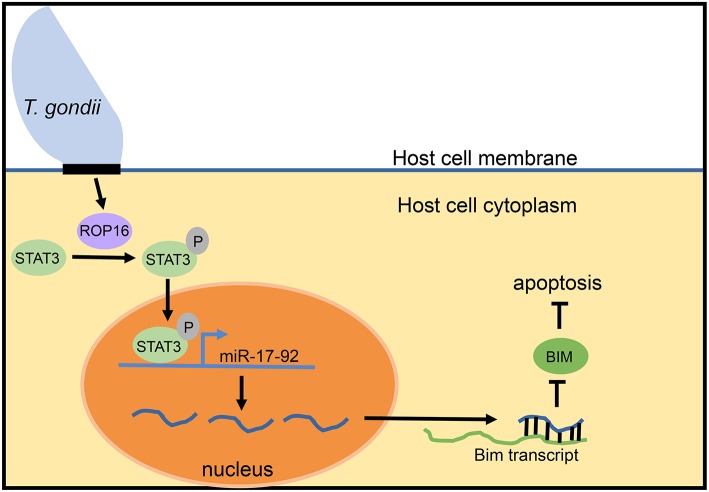
Model for mir-17-92 inhibition of apoptosis during T. gondii infection. During intracellular infection, T. gondii injects the ROP16 protein into the host cell cytoplasm. In the cytoplasm, ROP16 phosphorylates STAT3. Phosphorylated STAT3 enters the nucleus of the host cell, binds to STAT3 sites in the promoter of the miR-17-92 cluster gene, and upregulates miR-17-92 miRNAs. miR-17-92 cluster miRNAs then bind to the Bim transcript and reduce BIM levels, thereby inhibiting the process of apoptosis. This model is based upon data reported in Cai et al. (2013, 2014).